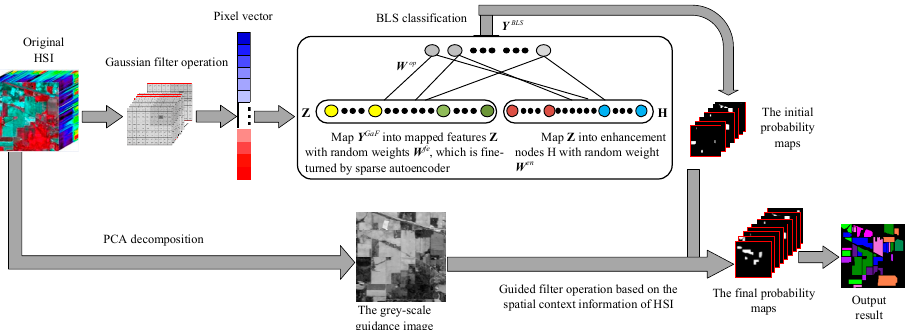
Figure 1. The flowchart of hyperspectral image (HSI) classification via the spectral-spatial joint classification broad learning system (SSBLS).